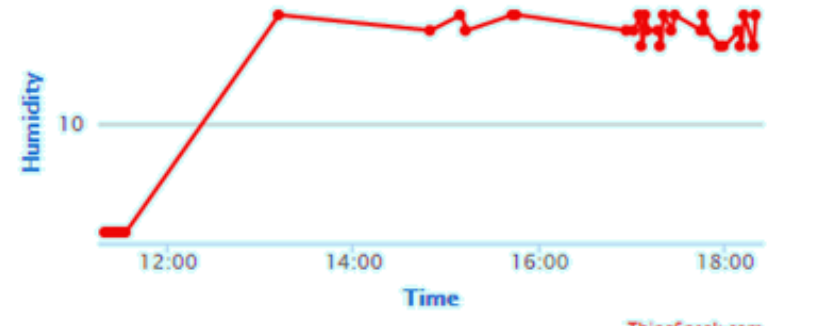
Figure 23. DigiIncubator: ThingSpeak humidity vrs.